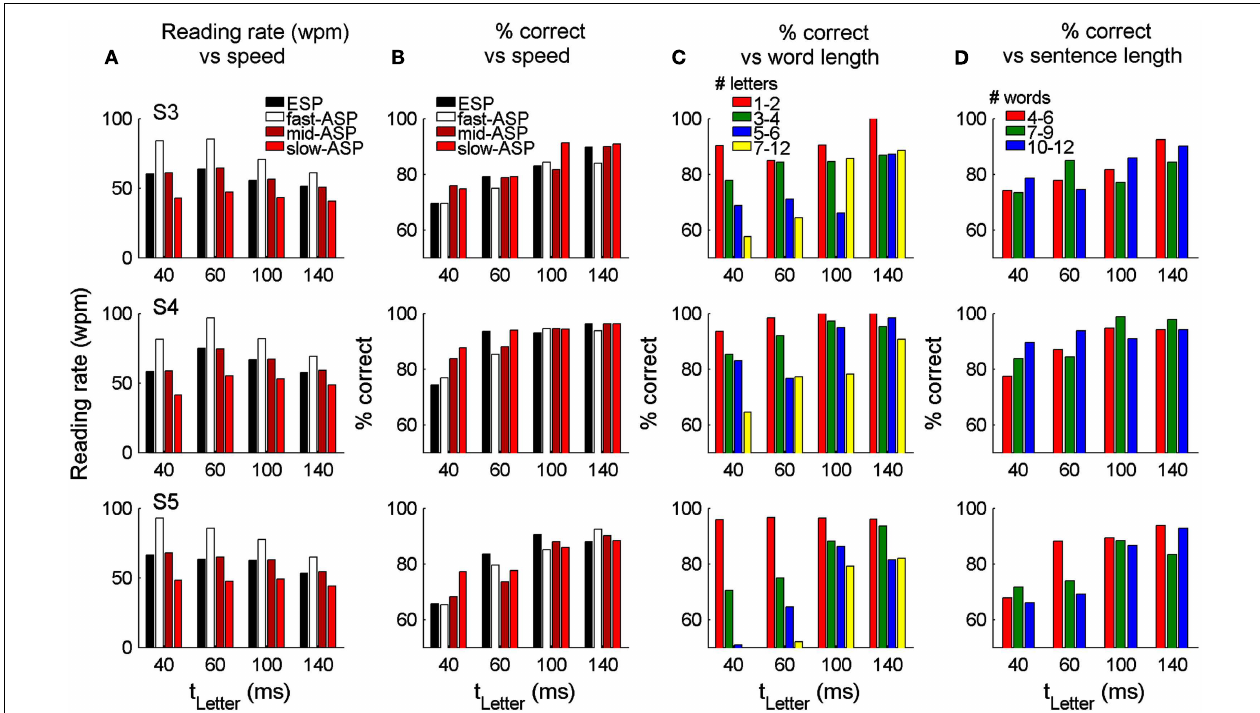
user control.The average inter-word timing defined the automatic inter-word timing used in the mid-ASP-Words mid condition. Inter-word timings in the fast and slow-ASP-Words conditions were 2/3 and 3/2 of the mid-ASP-Words rate, respectively. (C) Word identification performance as a function of word lengths (C) and sentence lengths (D) for the mid-ASP-Words